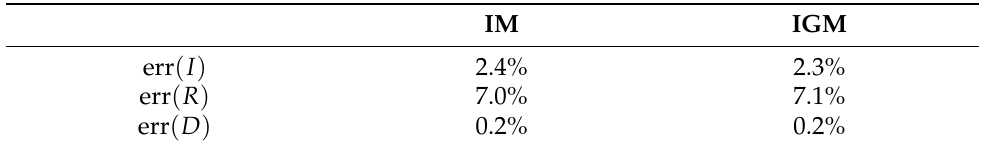
Figure 3. Time course of ˆ I , ˆ R and ˆ D data (yellow dots), and of the corresponding numerical solutions I , R and D , obtained with IM (red lines) and IGM (blue lines). Table 2. Fitting results. Percentage errors between data and simulations, averaged over time for both IM and IGM models (see Equation